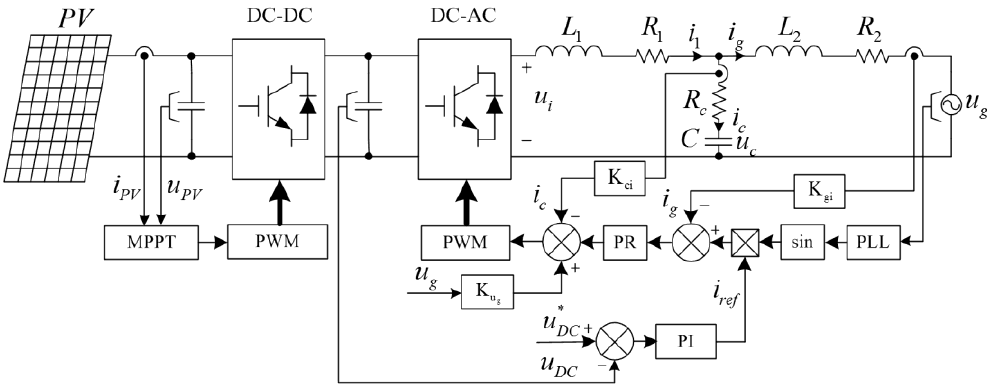
Figure 2. Two-stage single-phase PV system with LCL-filter control